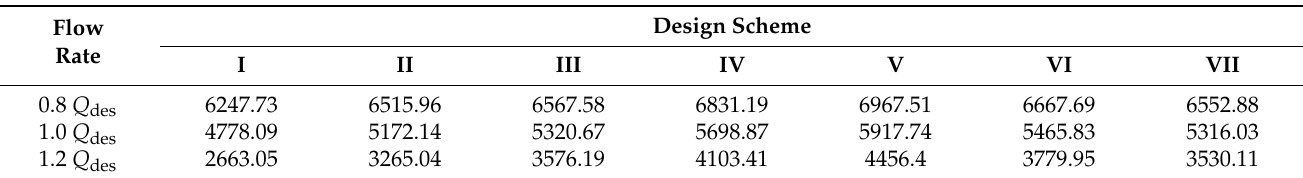
Table 6. Average axial forces.